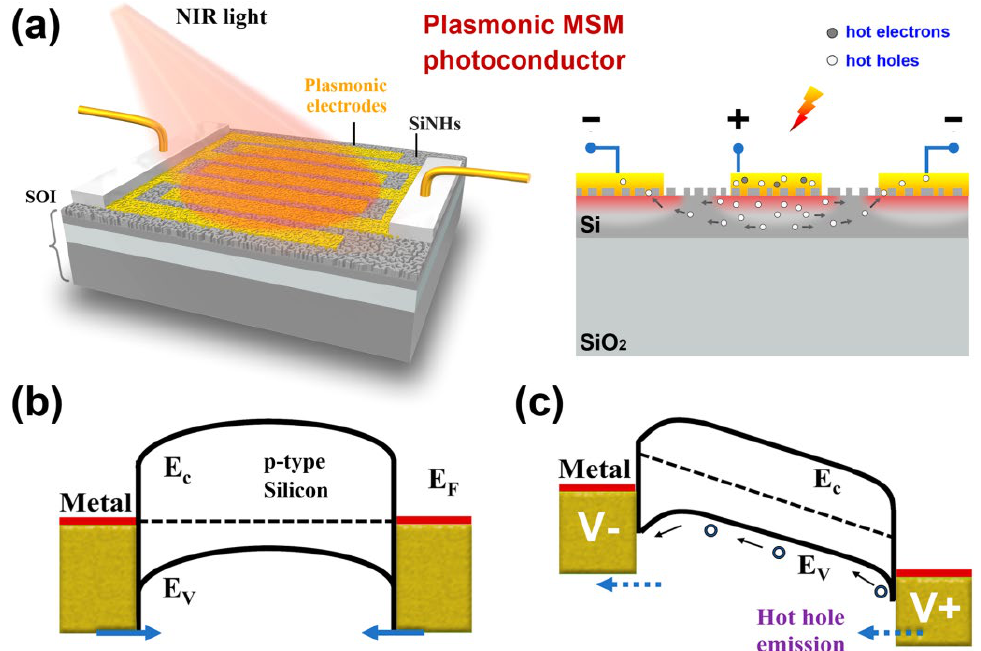
Figure 1. Plasmonic MSM photoconductor based on random Au/SiNHs. ( a ) Schematic drawing and work principle of the device. ( b , c ) Energy band diagrams of the MSM photoconductor under zero − bias and bias conditions.